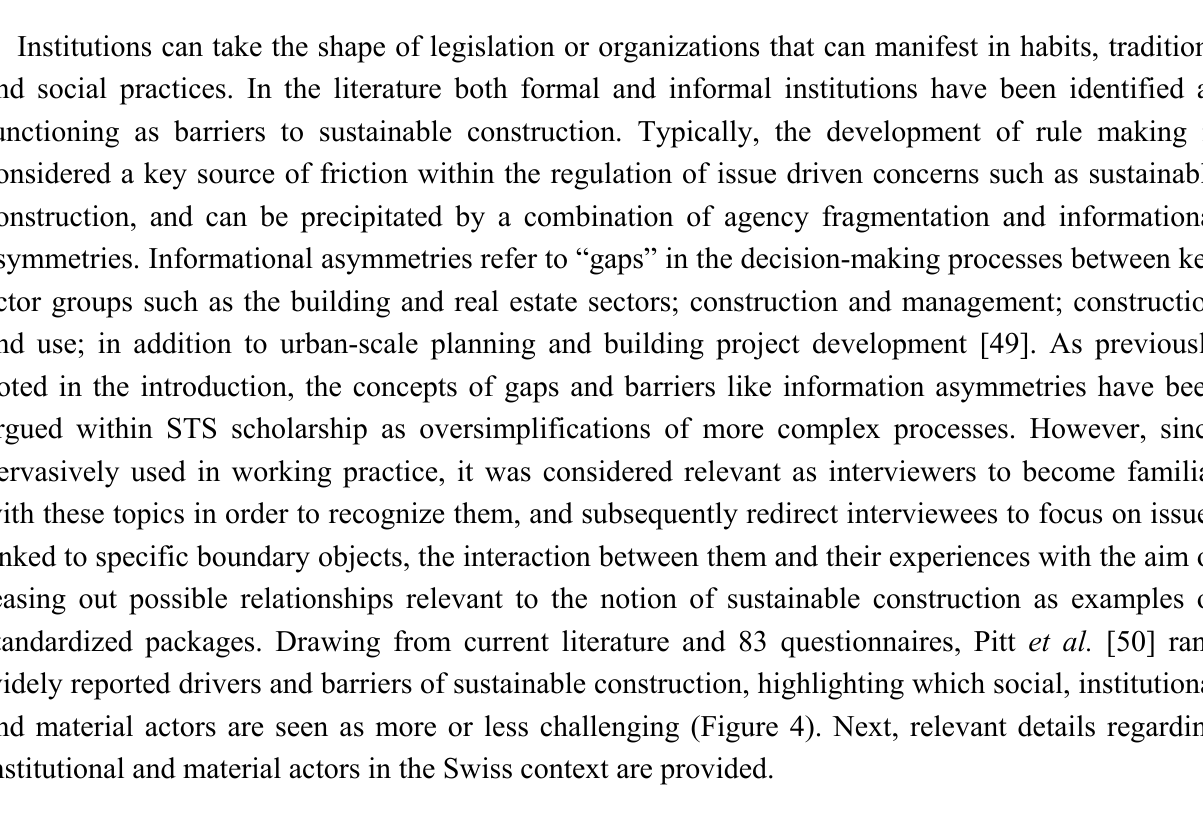
Figure 4. Perceived Drivers and Barriers to Sustainable Construction from Pitt et al .